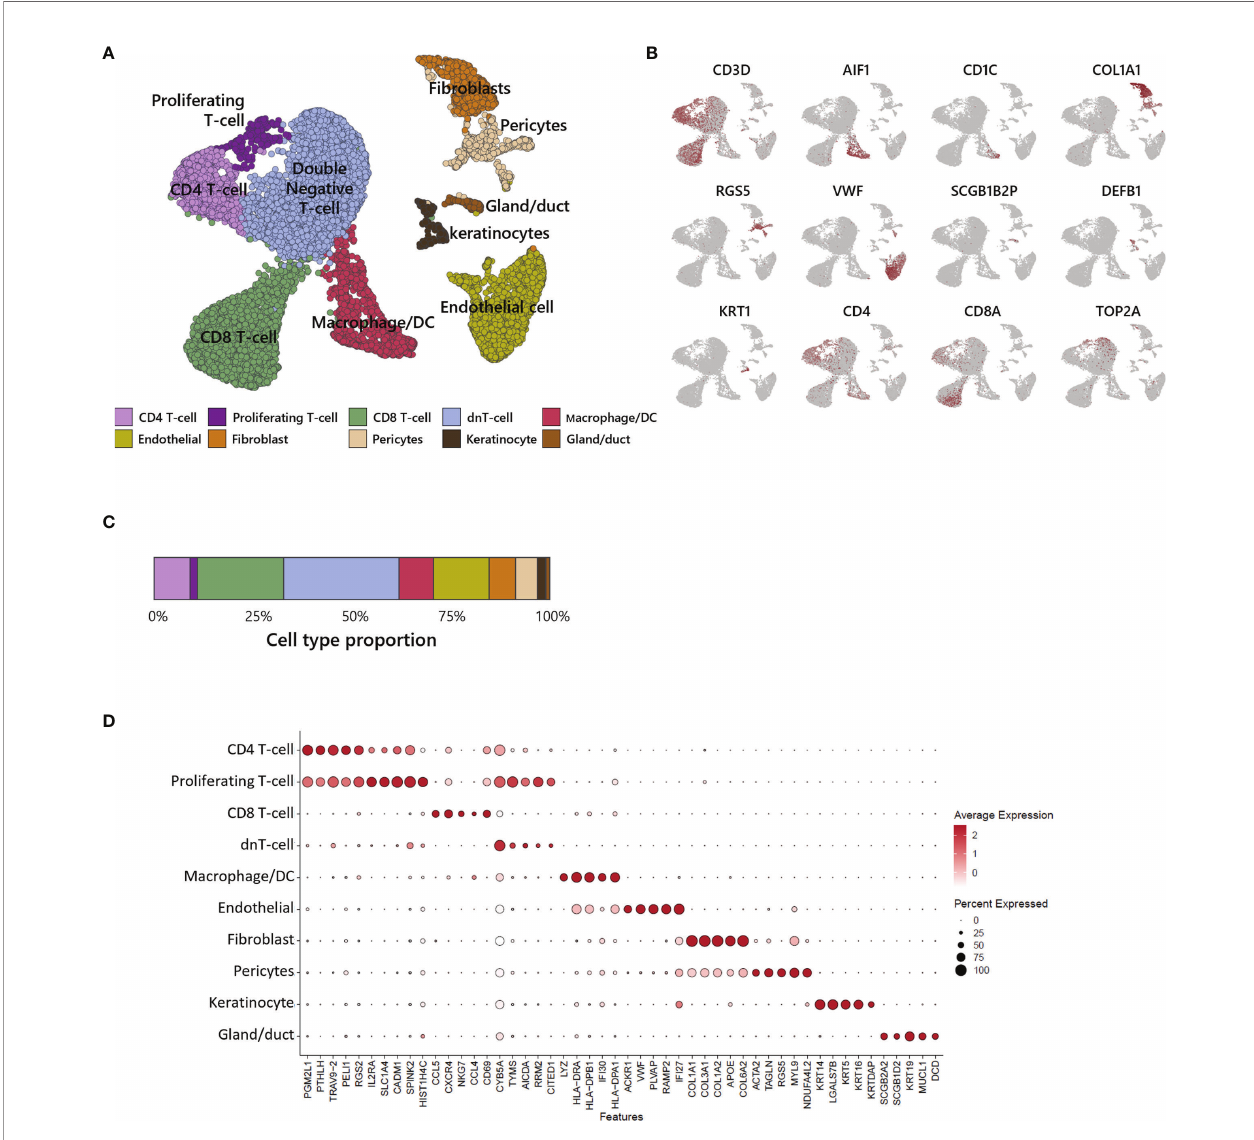
FIGURE 2 | Single-cell transcriptomic analysis of ATLL. (A) UMAP plot for 15,550 skin cells clustered by unsupervised Seurat clustering and annotated with 10 cell types. (B) Each cluster is identi fi ed by canonical cell type marker expression. (C) Proportion of each cell type in ATLL skin sample. (D) Dot-plot showing scaled average gene expression of the top 5 differentially expressed genes in each cluster of (B)